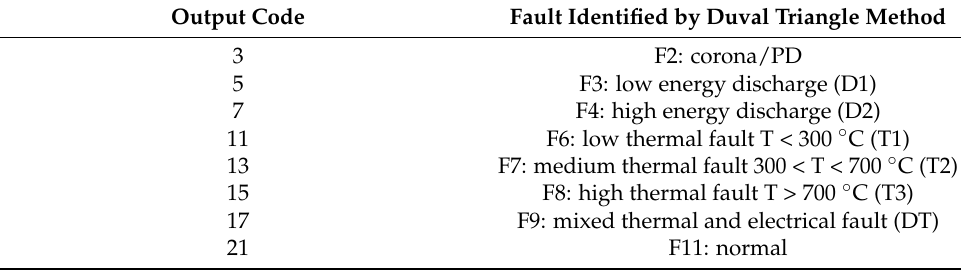
Table 10. Fuzzy output code, function and fault type using Duval triangle